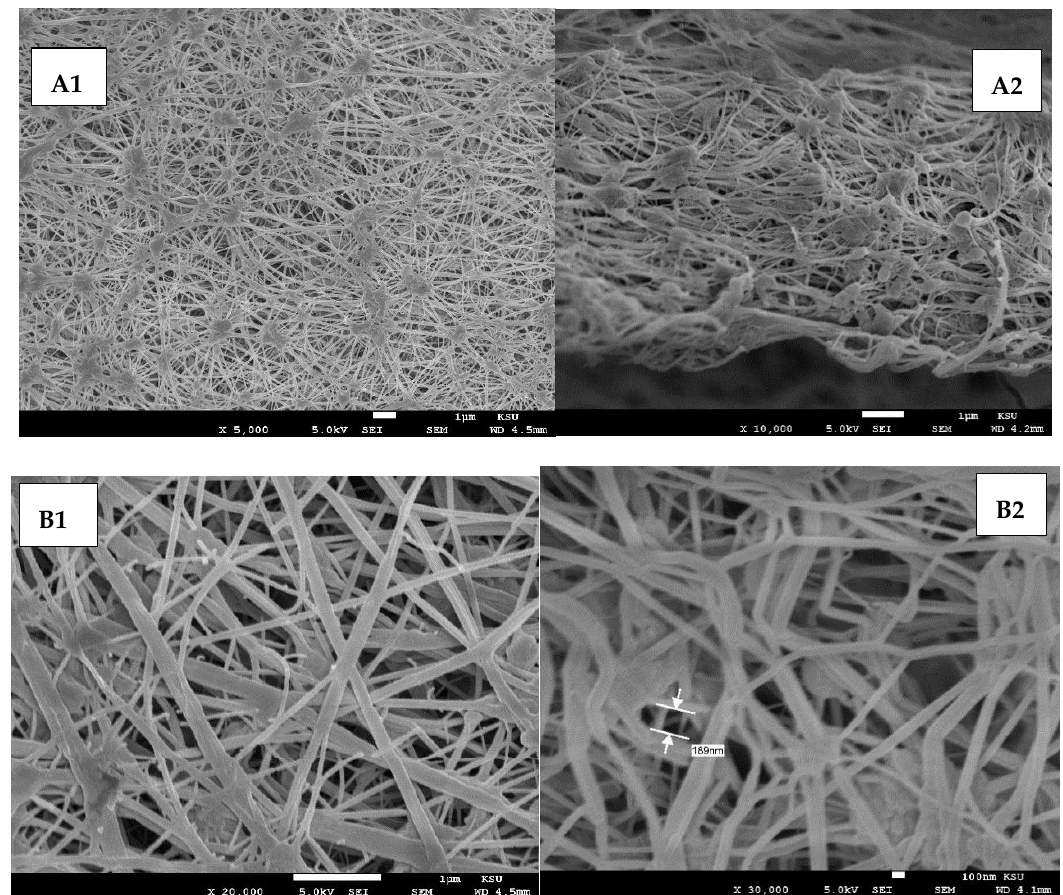
Figure 6. SEM images for PTFE membrane: ( A1 ) surface image for new membrane, ( A2 ) cross section image for new membrane, ( B1 ) surface image for used membrane, and ( B2 ) cross section image for used membrane at feed temperature = 70 °C and initial boron concentrations at 30 ppm.